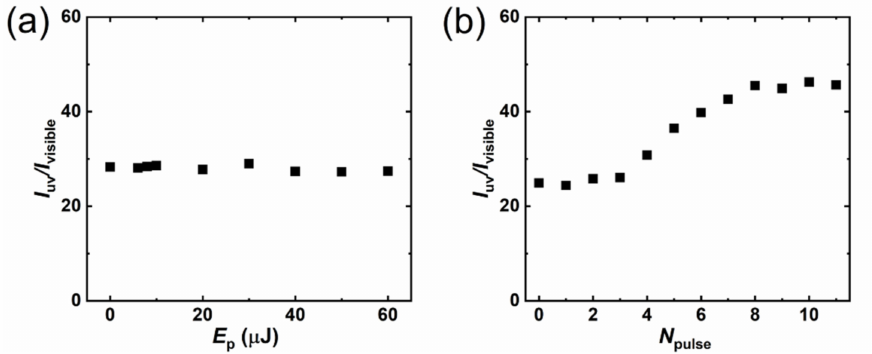
Figure 9. The intensity ratio of UV and green luminescence. ( a ) One-pulse irradiated spot; ( b ) multi-pulse irradiated spot (repetition rate, 10 Hz). The zero-J and zero-pulse samples in the graph indicate the results of unprocessed